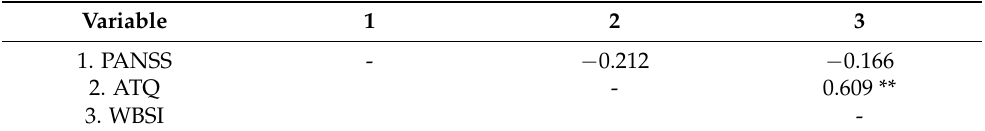
Table 3. Zero-order correlations between the variables in the study for Individuals with Primary Psychotic Disorder (PPD).